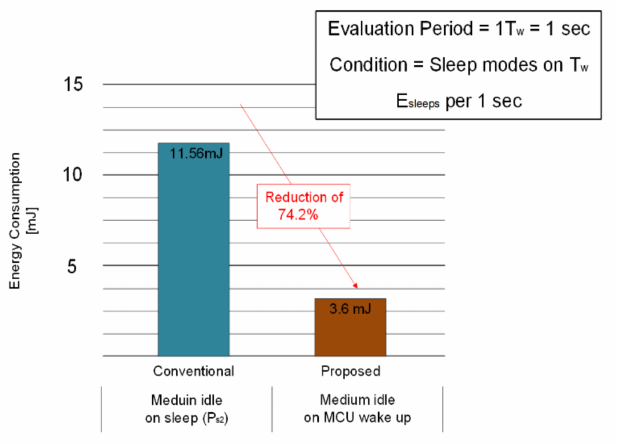
Figure 10. Comparison of energy consumption in the sleep mode.